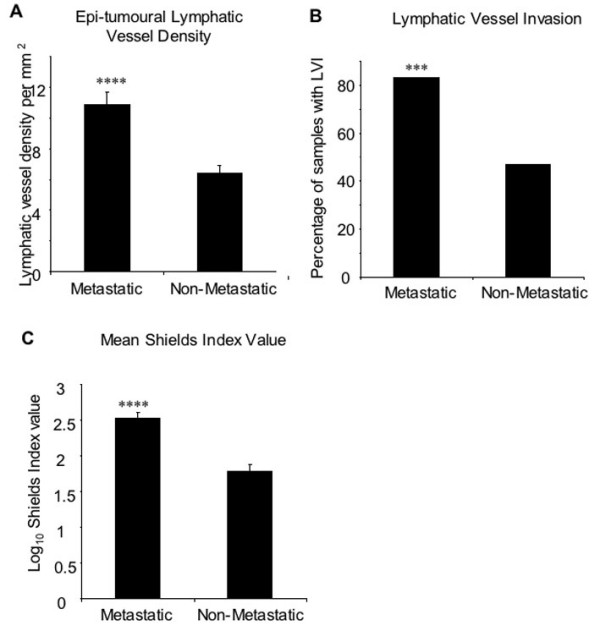
Mean epi-tumoural lymphatic vessel density and lymphatic vessel invasion. Lymphatic vessel density was significantly higher in tumours from patients that subsequently developed metastases (metastatic), compared to non-metastatic tumours (p < 0.0001, unpaired t test). B) There were a greater percentage of tumours with signs of LVI in the metastatic patient group compared to the non-metastatic group (p < 0.001 Fisher's Exact Test). C) Shields Index values were calculated by combining peritumoural LD, LVI and Breslow thickness. Mean Shields Index value was significantly higher in patients that subsequently developed metastases (metastatic), compared to non-metastatic tumours (p < 0.0001, unpaired t test). Error bars represent standard error of the mean